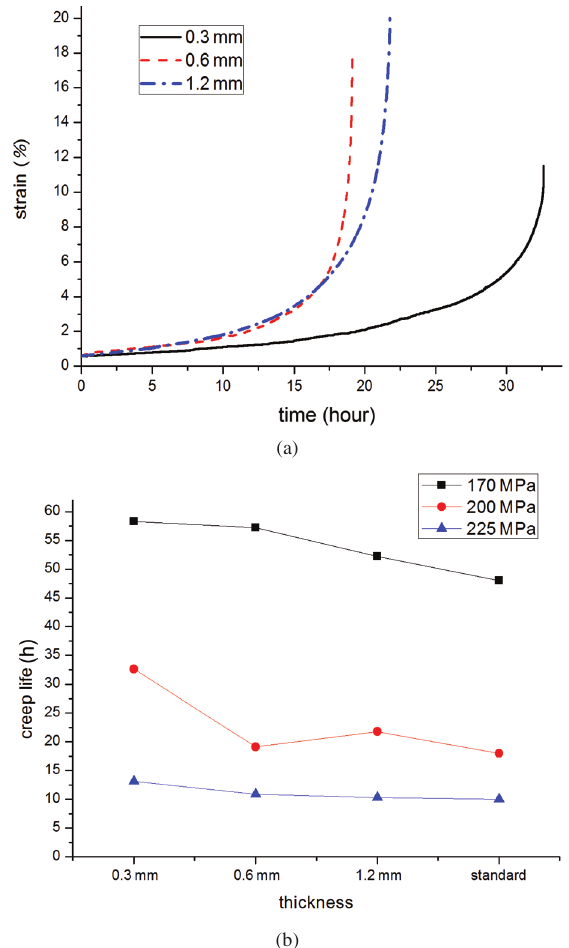
Figure 6: (a) Creep strain vs. time, curves for sheet specimens with δ = 0.3 mm, 0.6 mm and 1.2 mm tested at 1,100 ℃ /200 MPa. (b) Effect of specimen thickness on the average rupture life at 1,100 ℃ /170 MPa, 200 MPa and 225